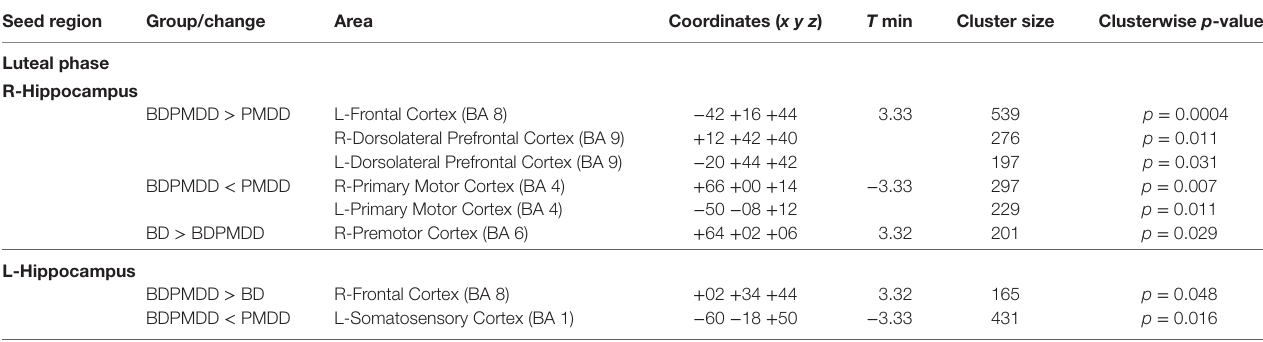
TaBle 4 | Differences in Rs-FC across groups.